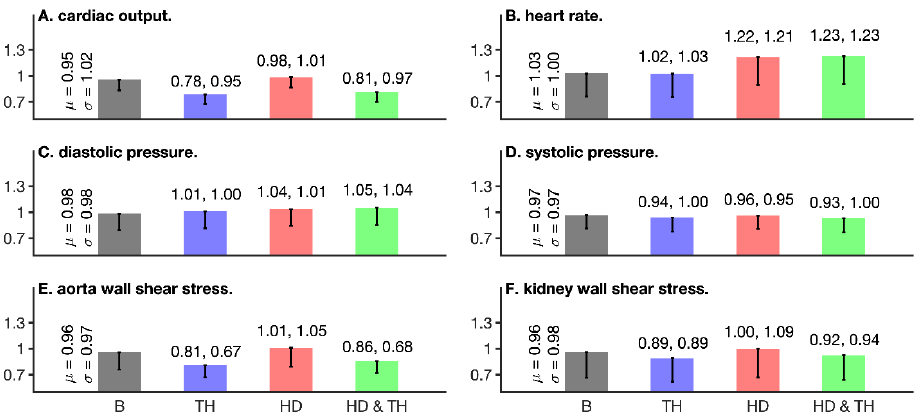
Figure 5. Effects of atrial fibrillation on clinical measurables. In all panels, data for atrial fibrillation [37] under baseline (B, gray bars), therapeutic hypothermia (TH, blue bars), dialysis (HD, red bars), and dialysis under TH (HD&TH, green bars) conditions are shown. Panel ( A ) shows cardiac output, ( B ) shows heart rate, ( C ) shows diastolic cardiac pressure, ( D ) shows systolic cardiac pressure, ( E ) shows WSS in the aorta, and ( F ) shows wall shear stress in the right kidney. Mean values and standard deviations relative to the non-atrial fibrillation baseline case (Figure 3, gray bars and corresponding values) are provided in all panels.